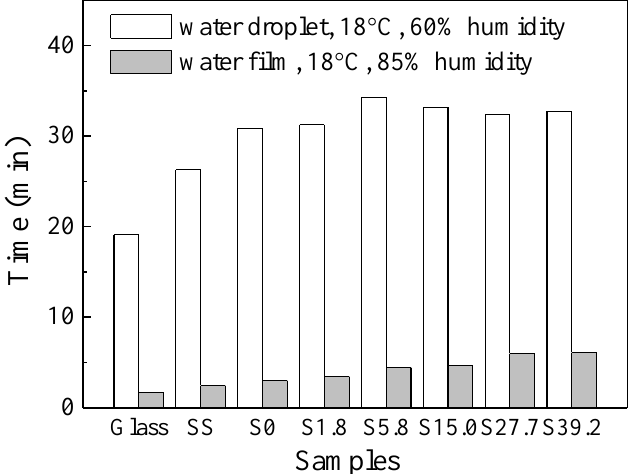
Figure 5. The drying time of 2 µ L water droplet and the sprayed water film on glass and Cr–Ag film samples.